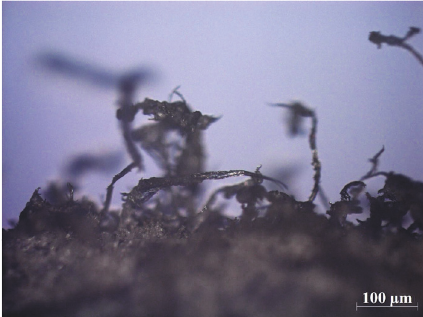
Figure 6: Fibril at the periphery of the extruded moulded